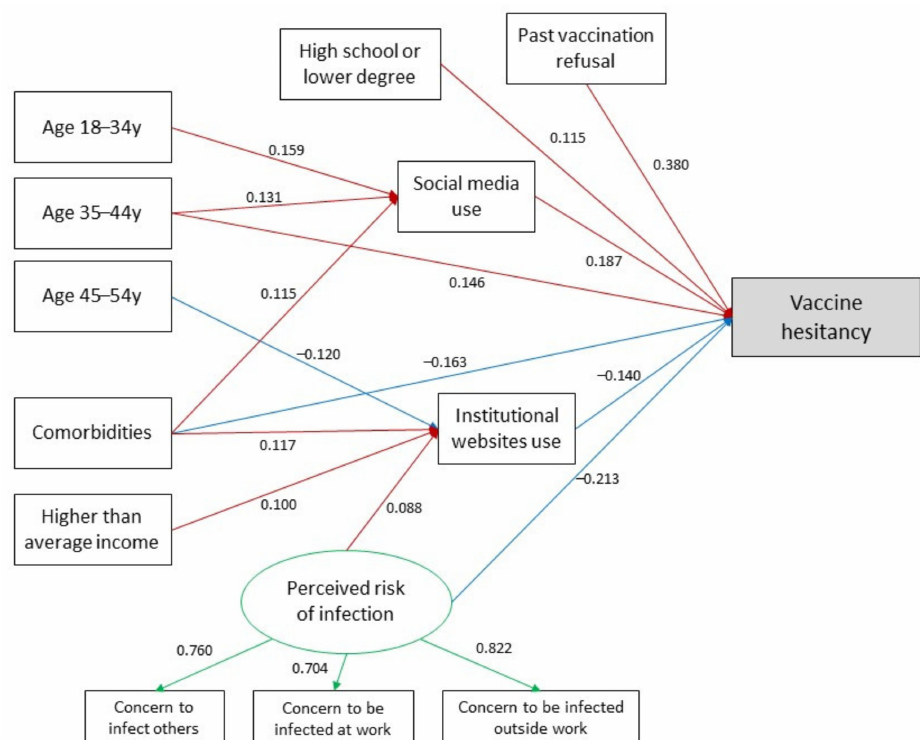
Figure 1. Final mediation model. Red lines denote positive effect and blue lines denote negative effect. Numbers on red and blue arrows represent standardized regression coefficients. Green lines denote the perceived risk of infection latent factor and the relationship with the corresponding observed variables. Numbers on green arrows represent standardized factor